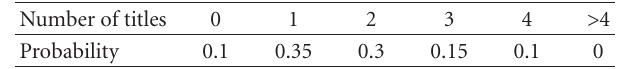
Table 2: Model used in analyses here of probability of number of video streams per IP video subscriber in the busy hour (prime time). Average = 1.8 streams per